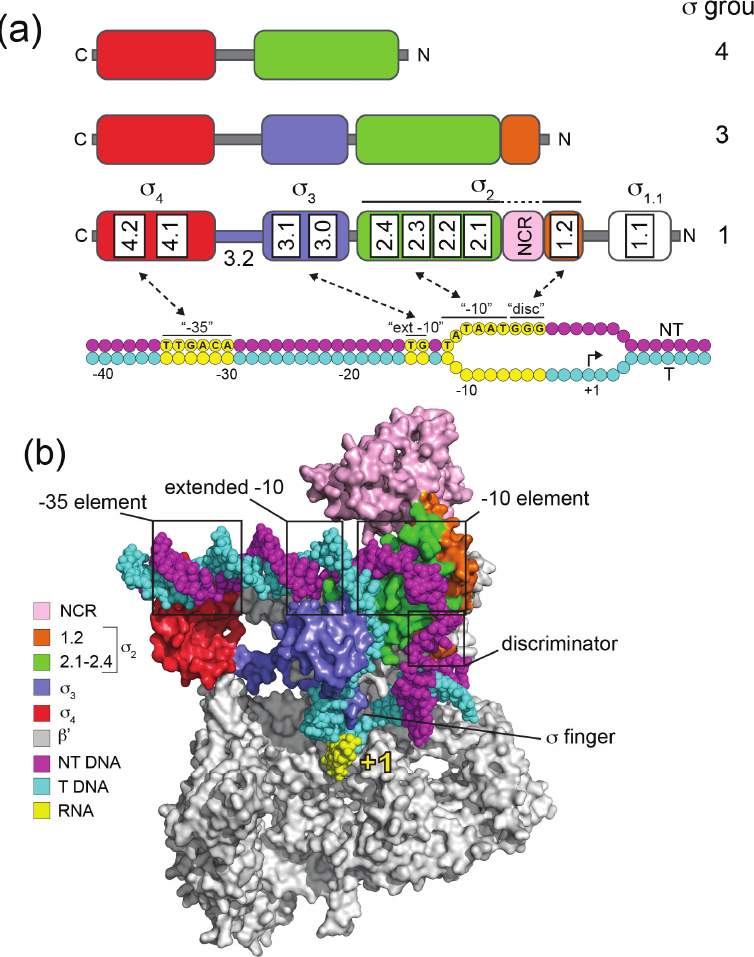
Figure 1. Domain organization, promoter recognition and structural organization of the (cid:2) 70 family. ( a ) The domain organization of (cid:2) factors from Groups 1, 3 and 4 are illustrated above (cid:2) 70 (Group 1) consensus E. coli promoter DNA. Structural domains are colored: (cid:2) 1.1 , white; (cid:2) 2 , green/orange; (cid:2) 3 , blue; (cid:2) 4 , red. Within each domain, conserved (cid:2) regions are indicated for Group 1 (cid:2)s. Non-template (NT) strand DNA is colored magenta and template (T) strand cyan, with key consensus promoter elements contacted by (cid:2) indicated in yellow: “(cid:6)35”, (cid:6)35 element; “ext (cid:6)10”, extended (cid:6)10 element; “(cid:6)10”, (cid:6)10 element; “disc”, discriminator. Transcription initiates at +1. Note that (cid:2) 2 is colored green and orange to distinguish (cid:2) regions 2.1–2.4 and 1.2. The nonconserved region (NCR; pink) located between 1.2 and 2.1 (pink) is variable in size and structure among Group 1 (cid:2) factors. ( b ) Organization of E. coli (cid:2) 70 in an RNA polymerase transcription initiation complex. The model was based on the crystal structure of an E. coli transcription initiation complex (PDB: 4YLN) [22]. (cid:2) 70 domains (surface representation) and promoter DNA (spheres) are colored as in (a), as indicated in the panel. For clarity the (cid:3), 2(cid:4) and (cid:5) subunits of RNA polymerase are omitted. The model indicates the location of the (cid:2) finger and its close proximity to nascent RNA (4 nt, yellow) and template strand